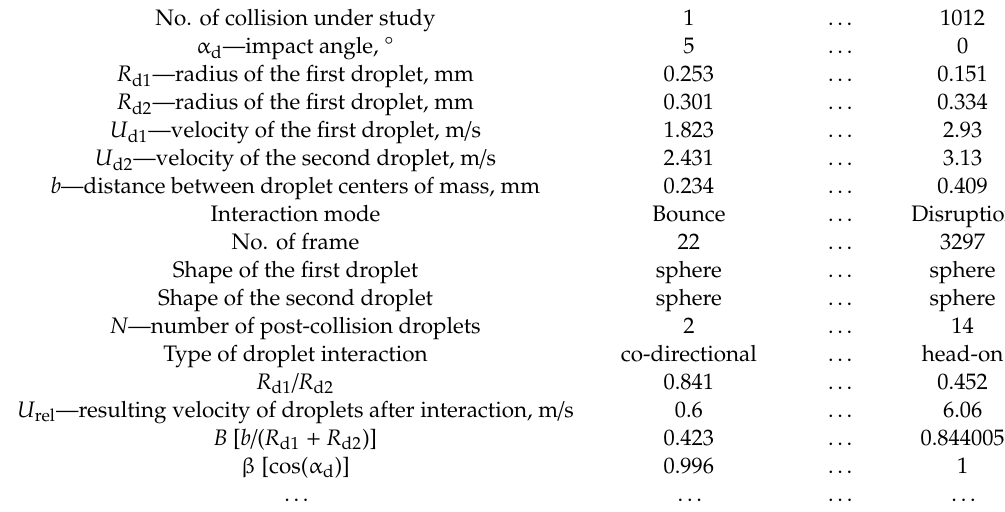
Table 2. Registered and calculated parameters of droplet